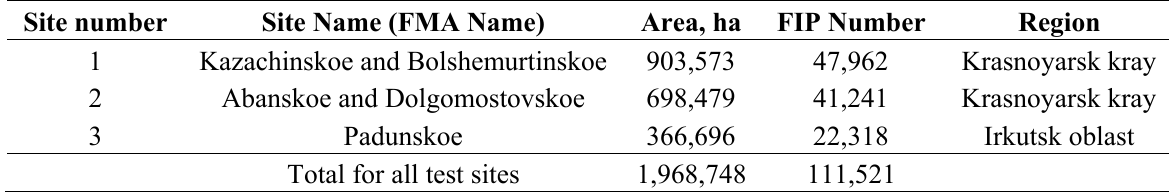
Table 3. Validation test sites.